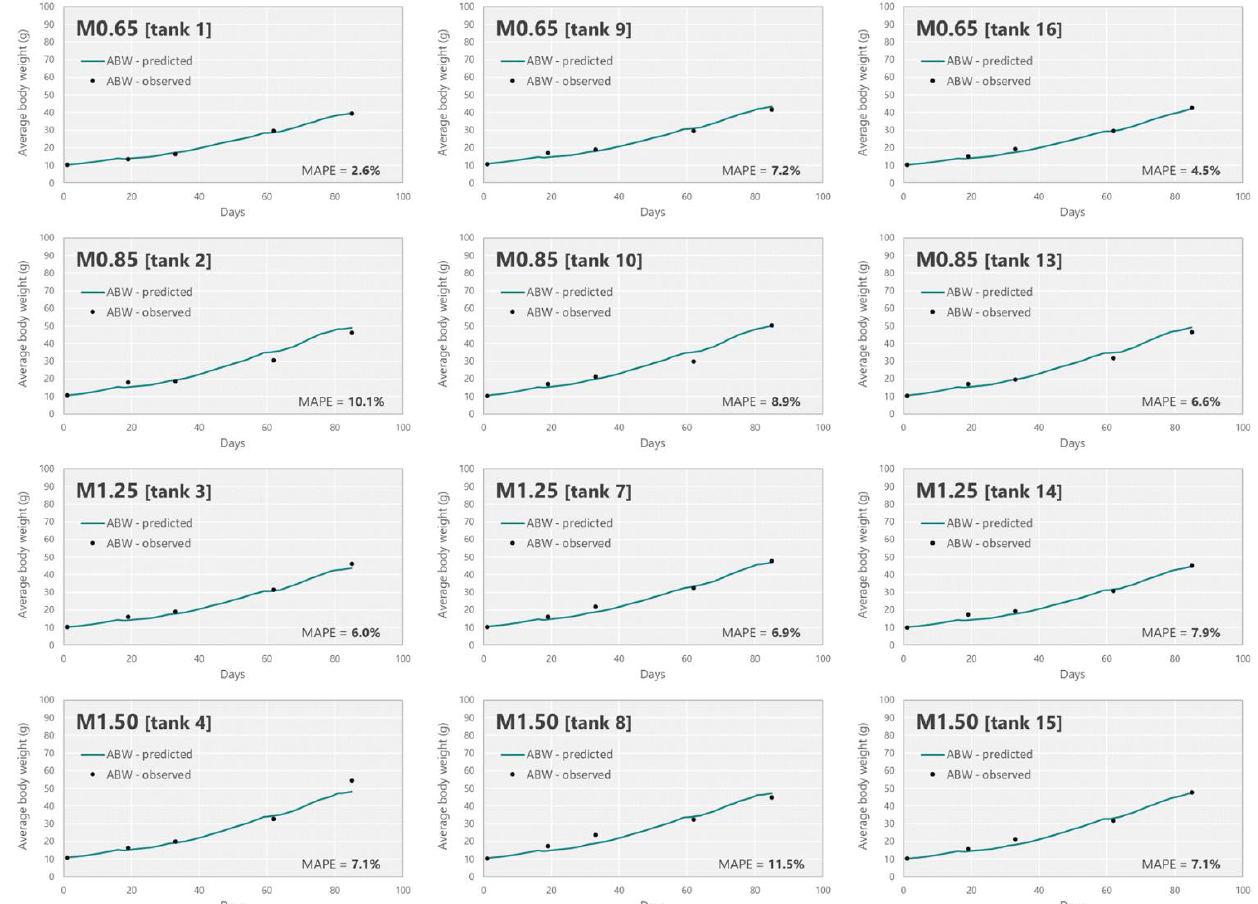
Figure 5. Time series of predicted (solid line) and observed (points) average body weight (ABW) for the Farinha et al. [32] data set, which includes experimental data about European seabass that were fed diets with different methionine levels (i.e., M0.65, M0.85, M1.25, M1.50). MAPE stands for mean absolute percentage error (%).